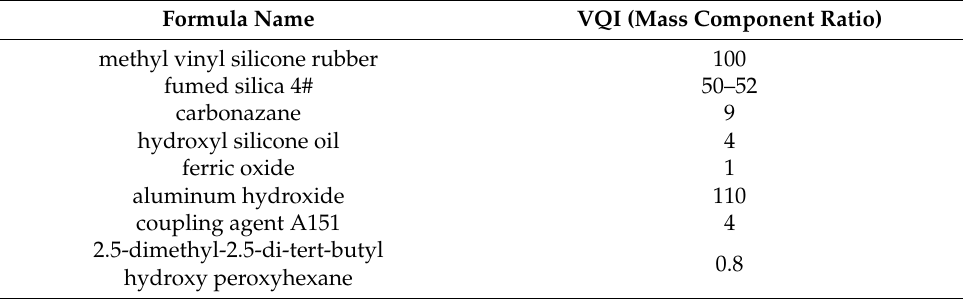
Table 1. Formula composition of test silicone rubber